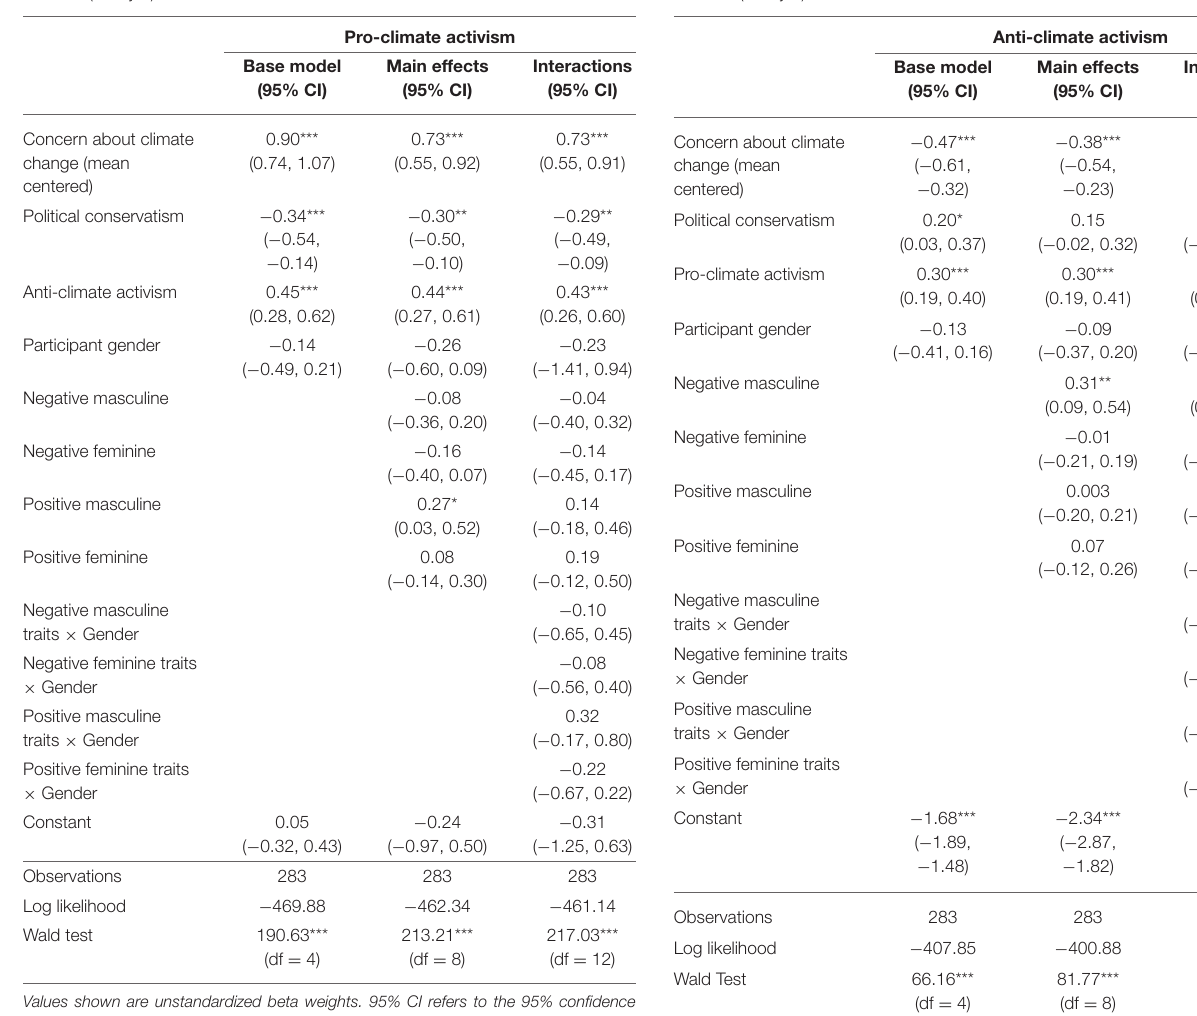
TABLE 3 | Impressions of the climate concerned as predictors of anti-climate activism (Study